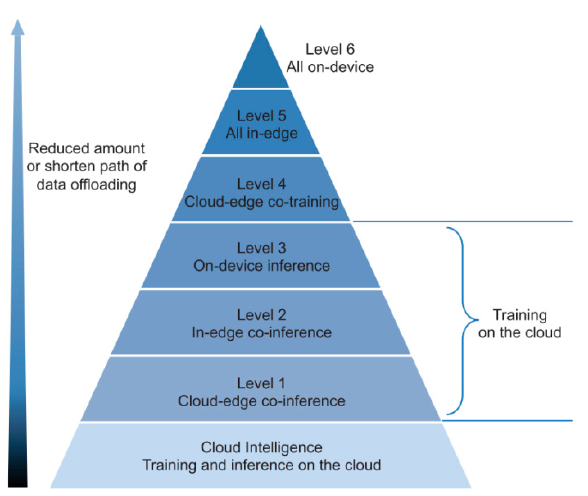
Figure 8. Six-level rating for edge intelligence [75].